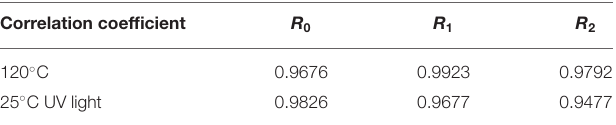
TABLE 3 | Correlation coefficients of zero-order, first-order, and second-order kinetic models for the lutein degradation. Correlation